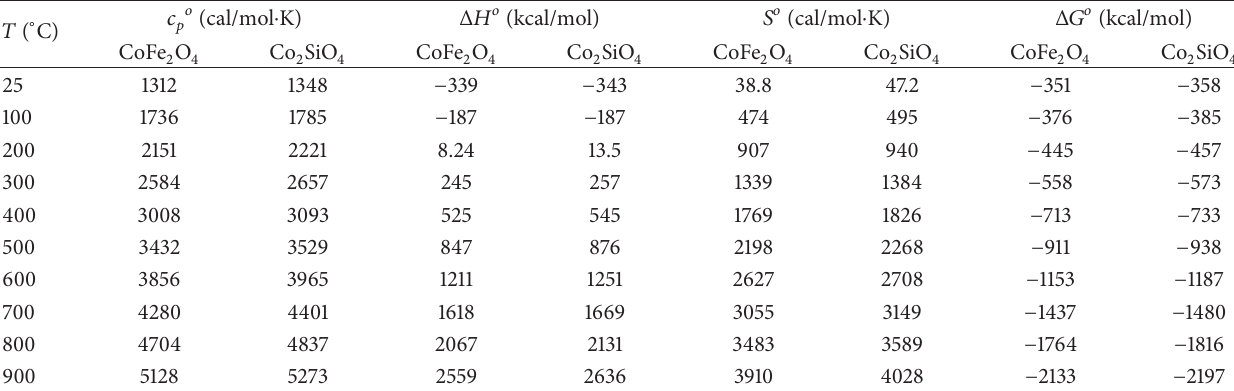
Table 4: Thermodynamic parameters at different temperatures for CoFe 2 O 4 and Co 2 SiO 4 .